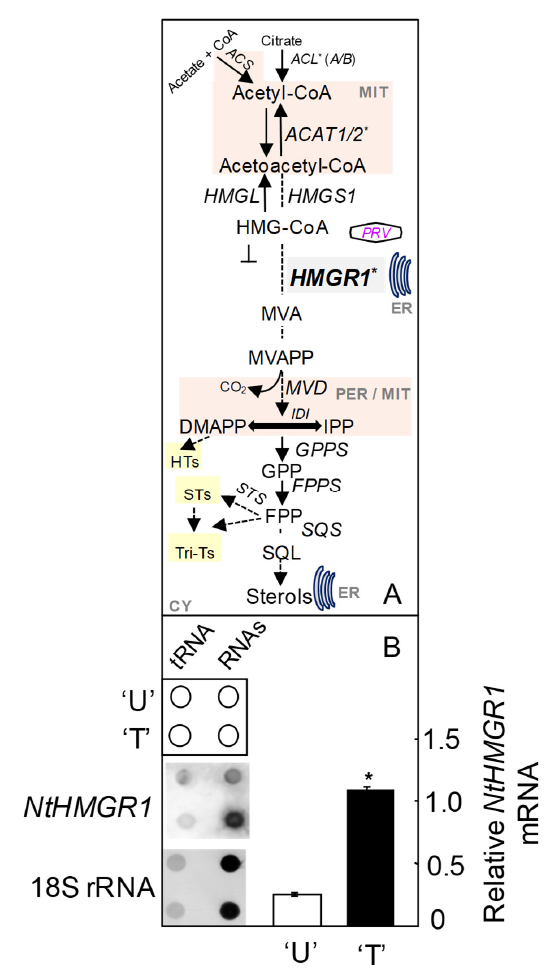
FigFigFigFigureureureure 2.2.2.2. Differential NtHMGR1 mRNA analysis. A. A simplified schematic representation of MVA biosynthesis pathway. Solid- and dashed-arrows indicate single- and multi-step reactions, respectively. The studied HMGR1 gene is highlighted in bold